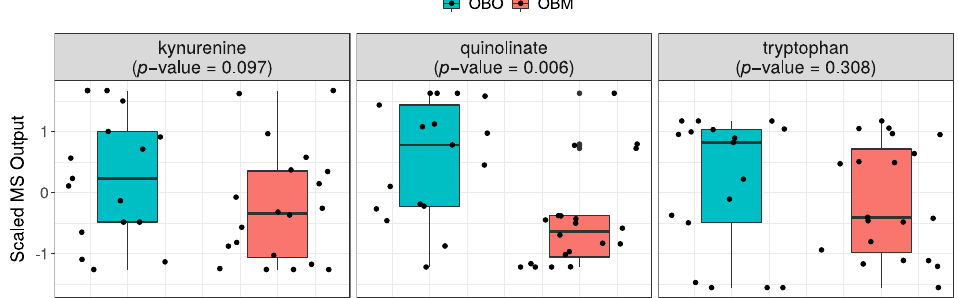
Figure 3. Distribution of kynurenine, quinolinate, and tryptophan in OBO ( left groups) and OBM ( right groups). The box plots are supplemented with violin plots to show distribution of samples across different MS values of the sphingomyelins.